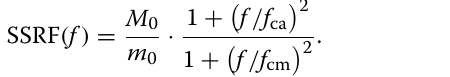
where r represents the equivalent radius for the SMGA (SMGA πr 2 ) and R indicates the equivalent radius of = the total rupture area, S ( S πR 2 ). We estimated S of = these eight events from the inversion models of previous studies (Yen 2002; Chi and Dreger 2004; Lee et al. 2015) according to the trimming criteria of Somerville et